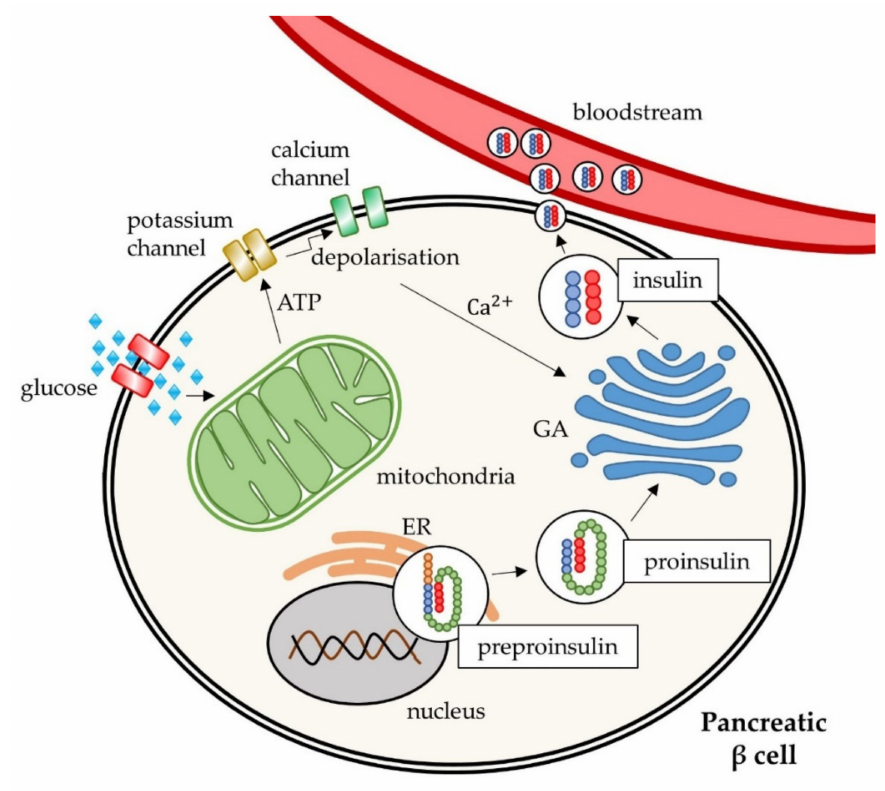
Figure 2. The mechanism of insulin release by pancreatic β -cells. ER: endoplasmic reticulum, GA: Golgi apparatus, ATP: adenosine triphosphate, Ca 2+ : calcium